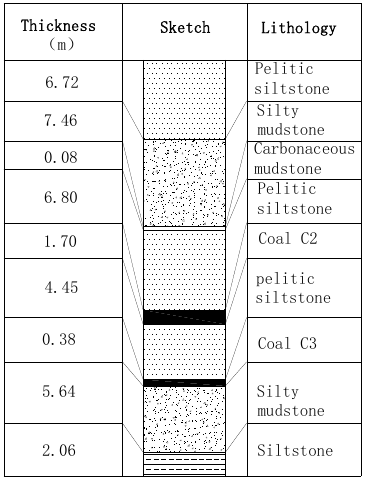
Figure 3. Lithological column diagram. Table 1. Rock properties of the roof and bottom slabs.